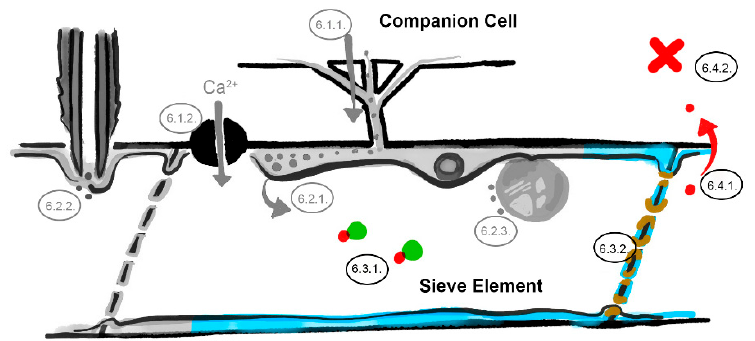
Figure 4. The phloem sap and sieve element–companion cell interface barriers. Interference with phloem-mobile chaperones (Section 6.3.1), occlusion of the sieve plate pores (Section 6.3.2), restricted virus unloading (Section 6.4.1) and systemic resistance factors (Section 6.4.2). Involved barriers are indicated in color (light blue = sieve element reticulum, red = virus identities, green = chaperone, brown = callose; numbers correspond to the listed mechanisms in the main text, image not drawn to scale).